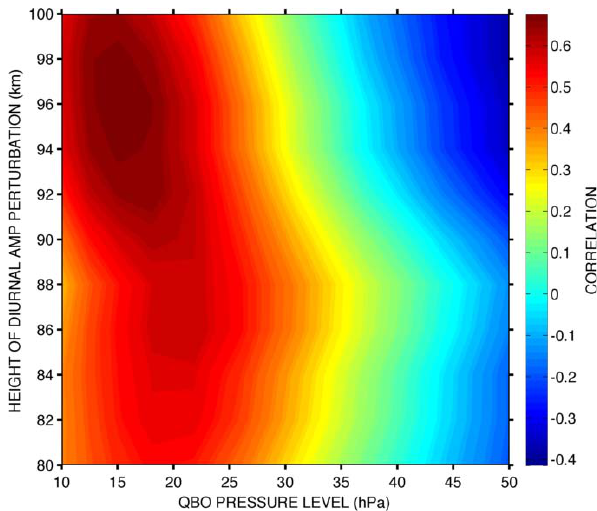
Fig. 16. Correlation between WACCM meridional diurnal tidal am- plitude perturbations and stratospheric QBO winds as a function of height and pressure level.